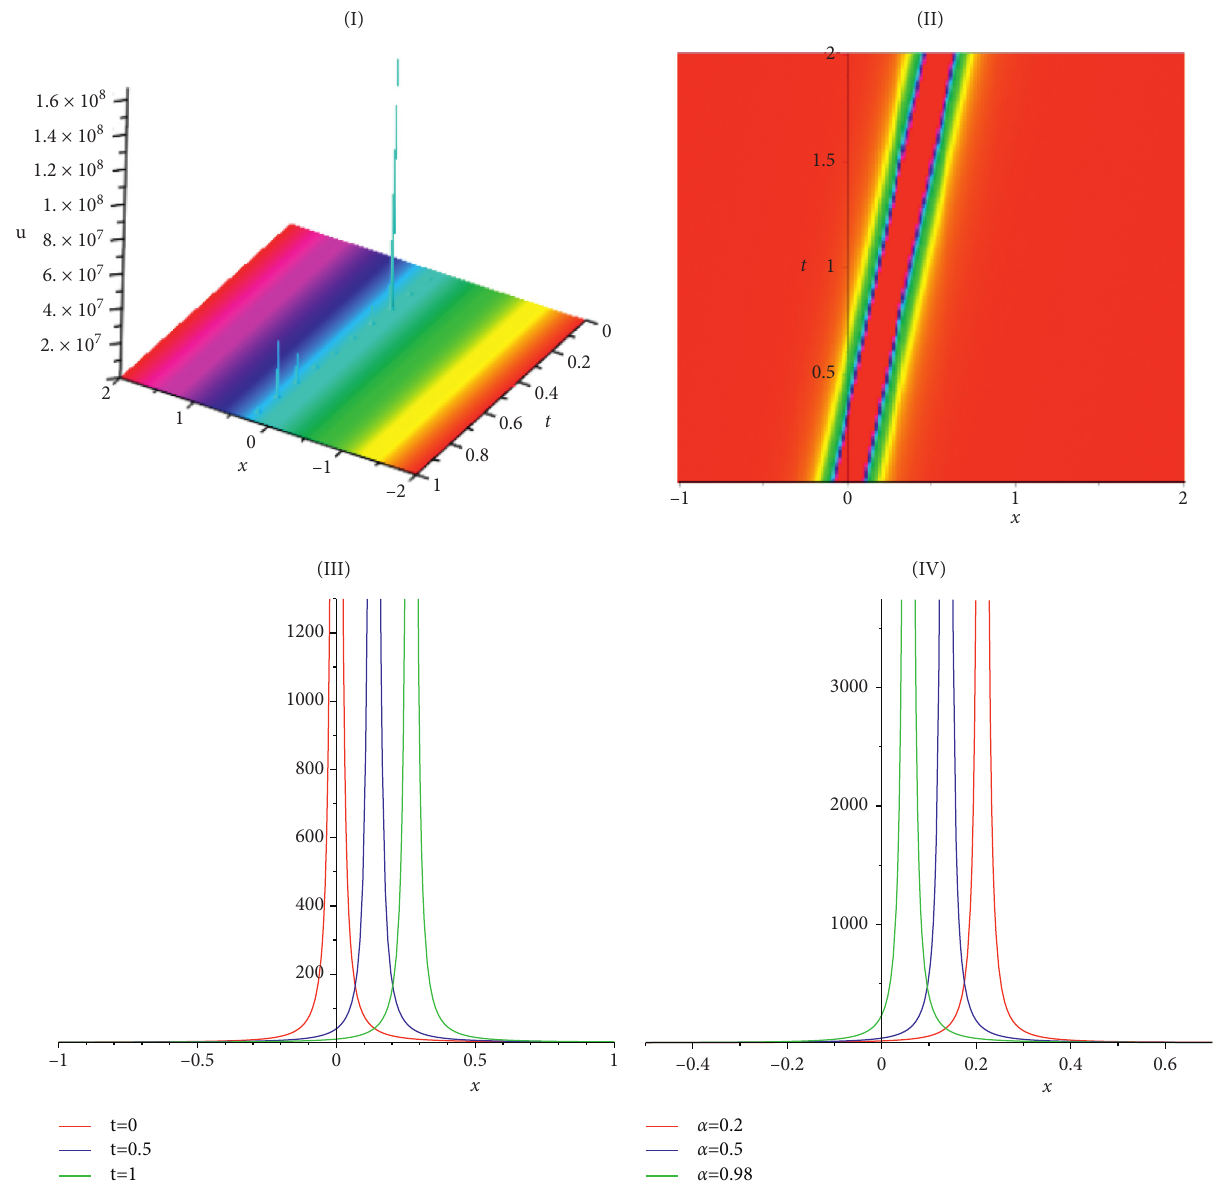
Figure 3: Evolution of the periodic solution (27) with data r � 2 ,k